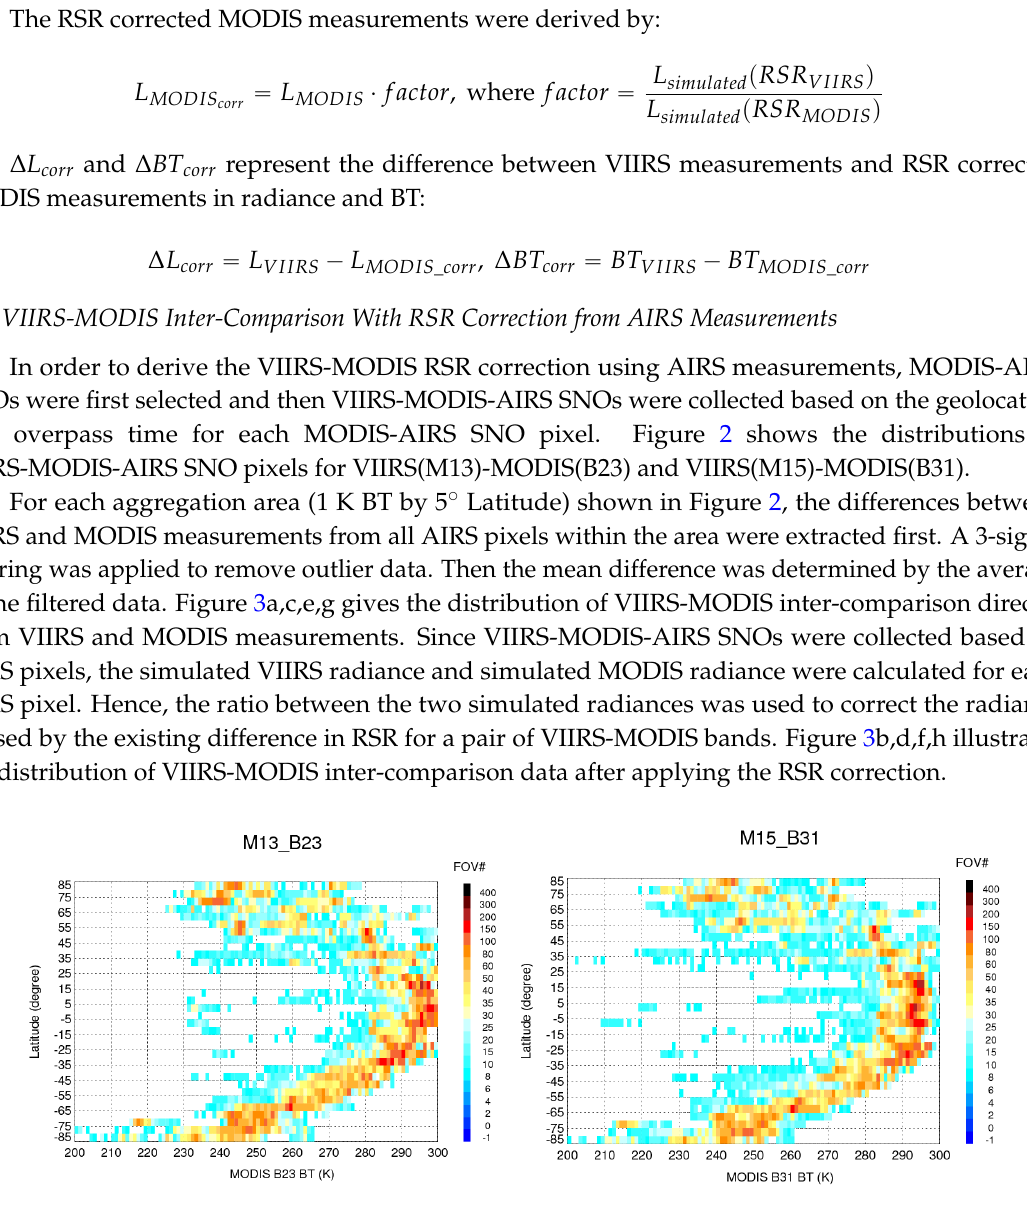
Figure 2. VIIRS-MODIS-AIRS SNO FOV number distribution.